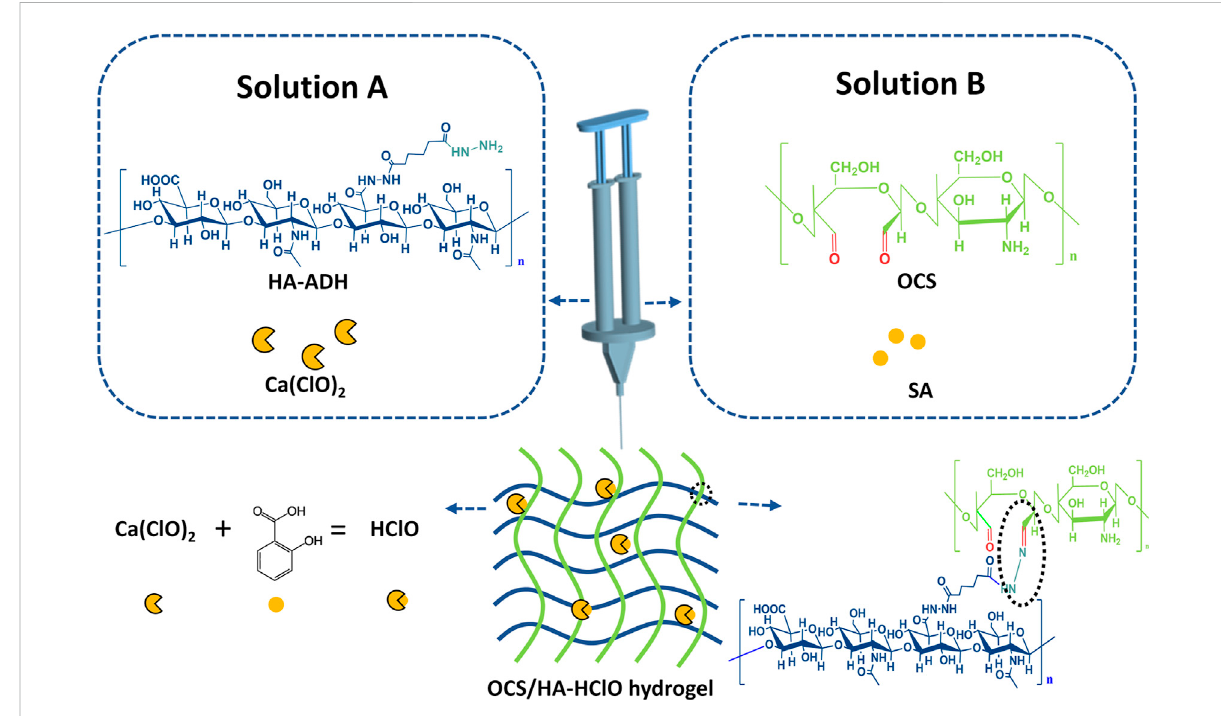
FIGURE 1 Fabrication of the OCS/HA-HClO hydrogel based on the reversible Schiff-based